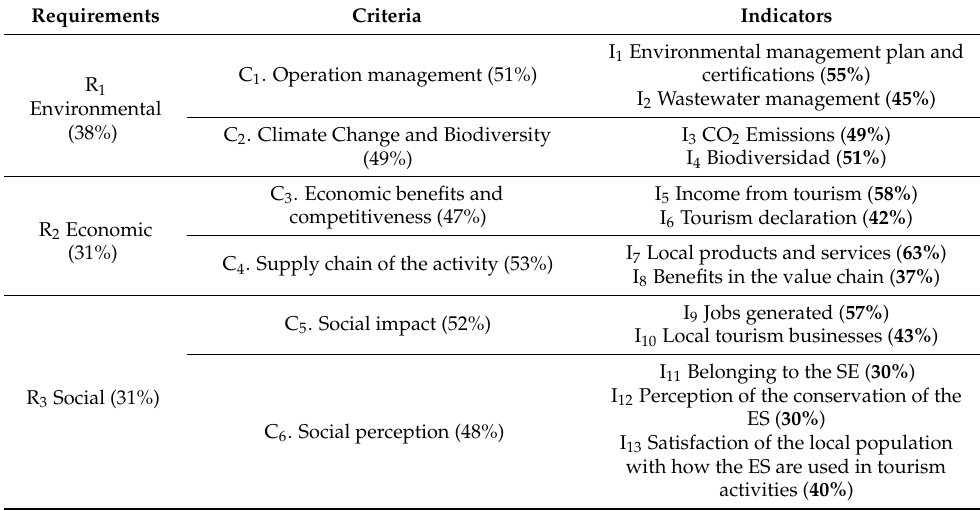
Table 1. Decision tree and weight evaluation. The values marked in bold represent the weights assigned for the